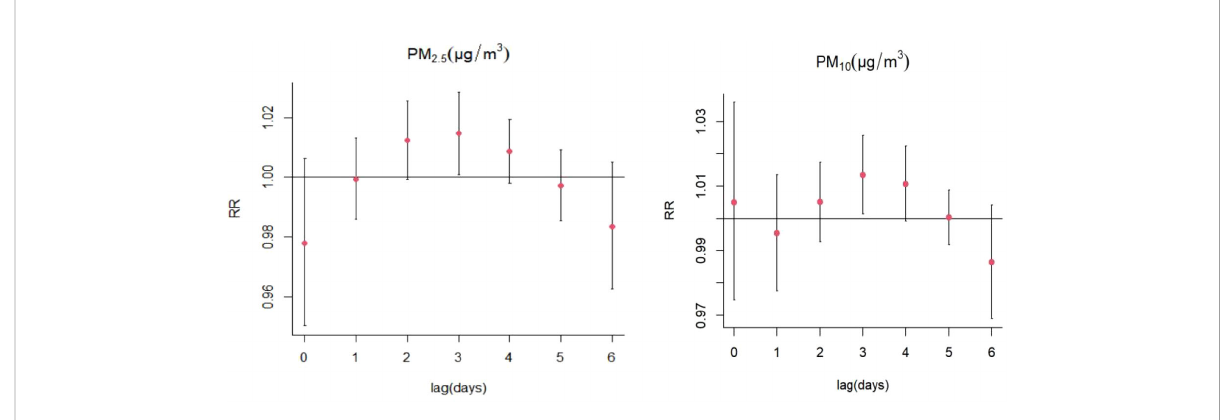
FIGURE 4 Lag-speci fi c relative risks (%) in hospitalizations for SS per 10 unit increase in daily mean concentrations of PM 2.5 , PM 10